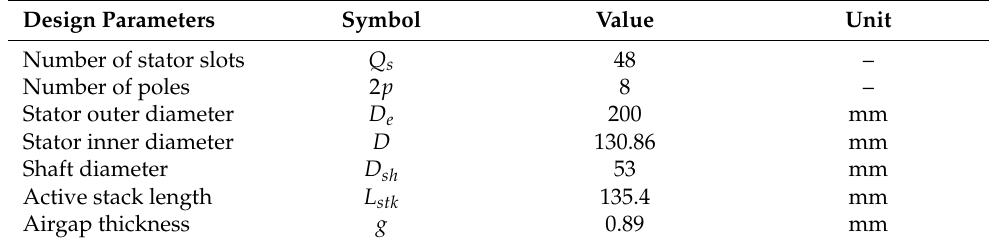
Table 1. Main Dimensions of the Lexus LS 600h IPM